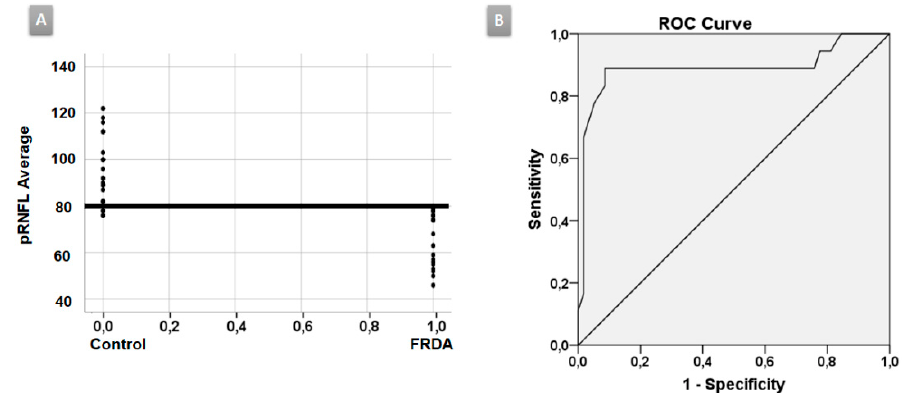
Figure 2. ROC curve. ( A ) The average peripapillary retinal nerve fiber layer (pRNFL) thickness was the best parameter to discriminate between Friedreich ataxia (FRDA) patients and healthy controls (HC) with an area under the curve (AUC) of 0.984. ( B ) The cut-o ff point was 80.5